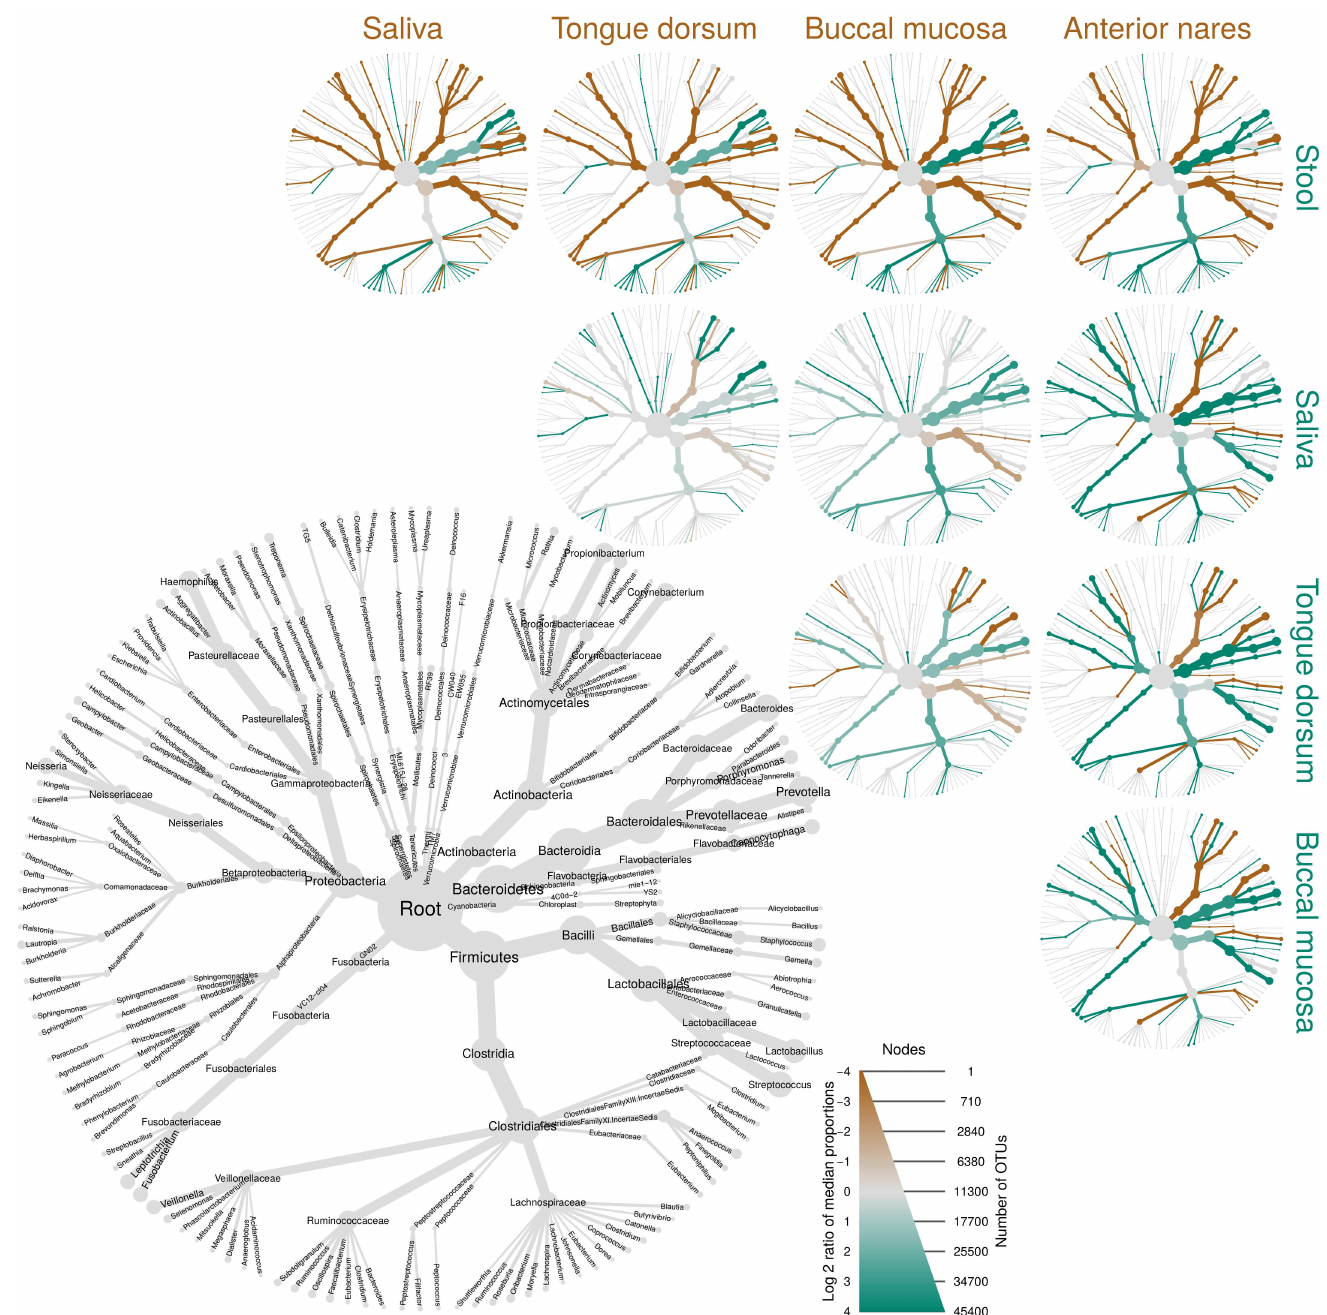
Fig 5. Scale-independent appearancefacilitates complex, composite figures. This graph uses 16S metabarcoding data from the human microbiome project study to show pairwisecomparisons of microbiome communitiesin different parts of the human body. All graph components, including text, have the same relative sizes independentof output size, unlikemost graphicalpackagesin R, making it easier to create composite figures entirelywithin R. The gray tree on the lower left functions as a key for the smaller unlabeled trees. The color of each taxon representsthe log-2 ratio of medianproportions of reads observed at each body site. Only significantdifferences are colored, determined using a Wilcox rank-sum test followedby a Benjamini-Hochberg (FDR) correction for multiplecomparisons. Taxa colored green are enrichedin the part of the body shown in the row and those coloredbrown are enrichedin the part of the body shown in the column. For example, Haemophilus , Streptococcus , Prevotella are enriched in saliva (brown)relative to stool where Bacteroides is